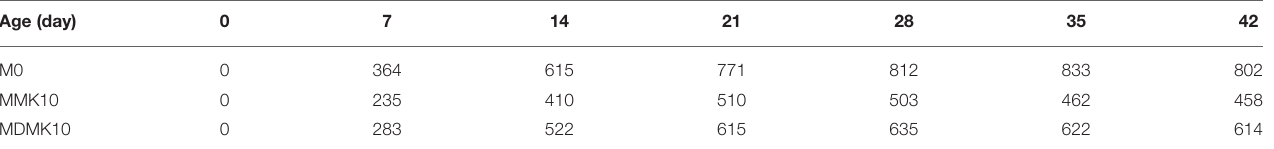
TABLE 8 | Shrinkage of mortar specimens ( × 10 − 6